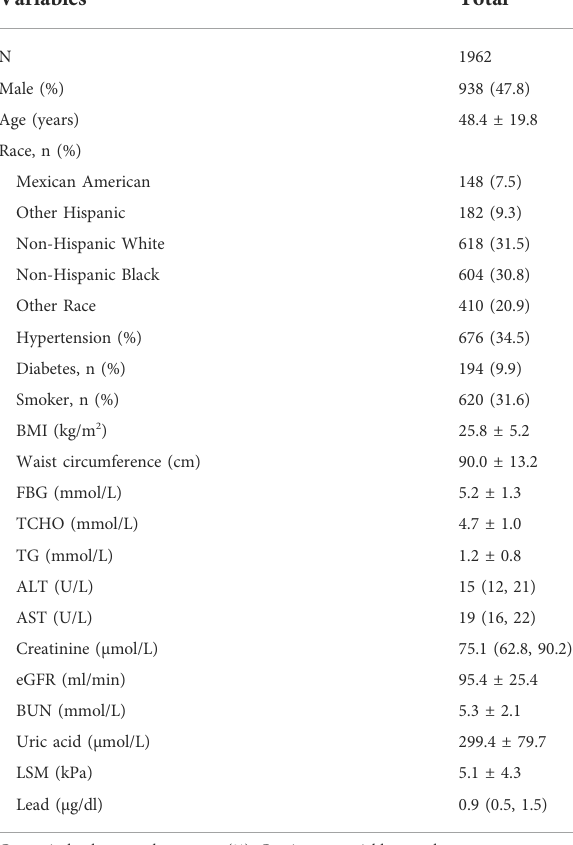
TABLE 1 The Characteristics of patients without